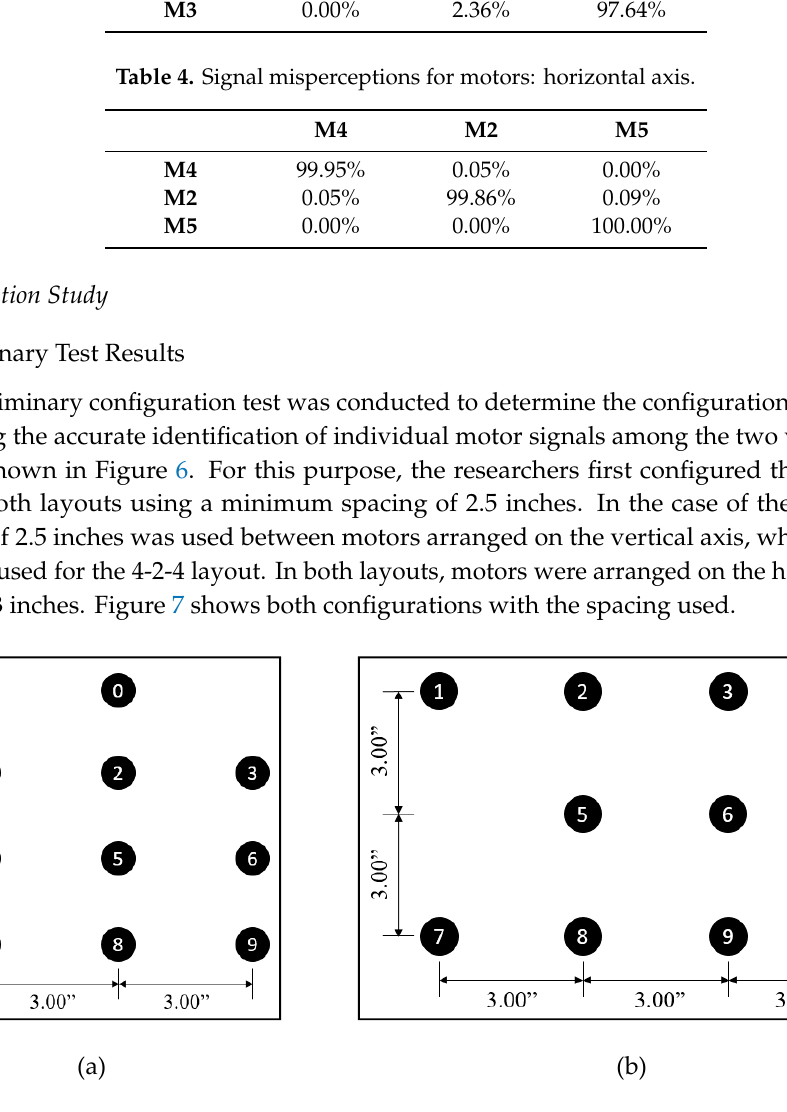
Table 5. Preliminary configuration test summary. Test Participant